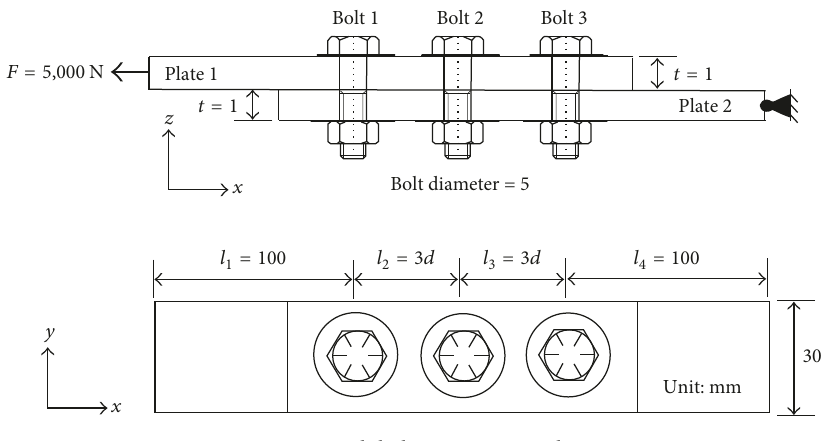
Figure 19: Multibolt connection analysis.